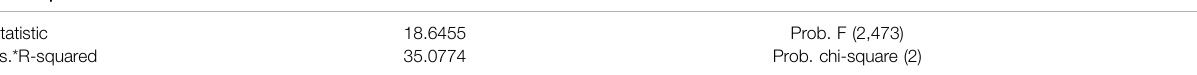
TABLE I | Autocorrelation test results for selected